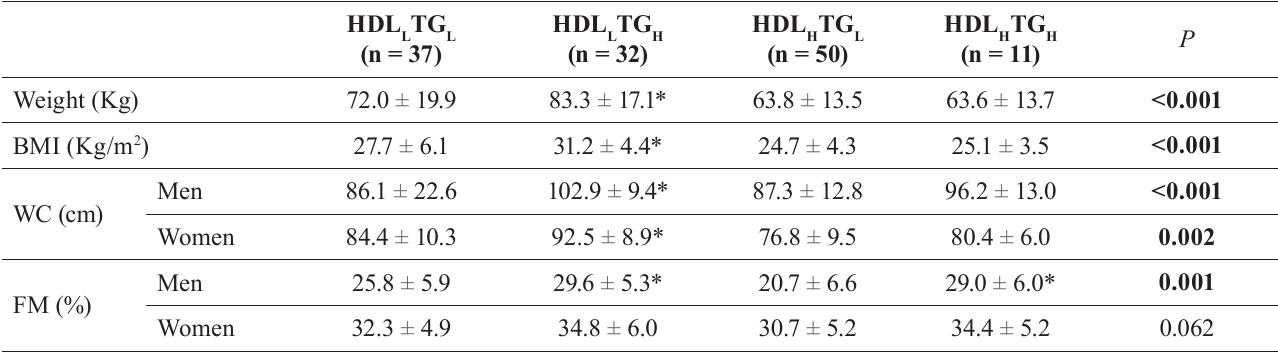
TABLE II - Anthropometric parameters and body composition of subjects